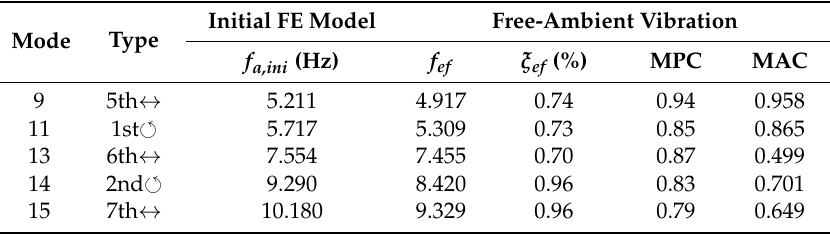
Table 2. The higher modes that can only be extracted from combined free-ambient